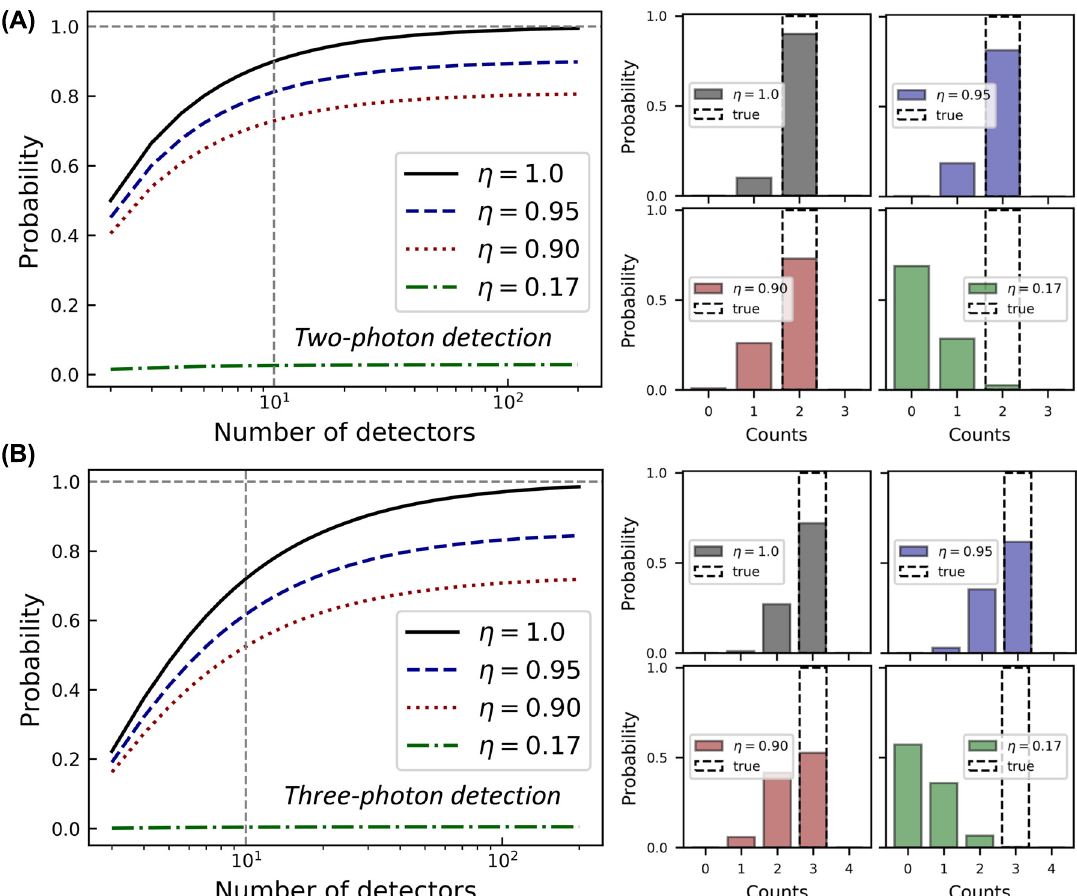
Figure 6: Photon number resolution with coherent and incoherent detection. (A, left): The probability of getting two clicks assuming detection of a two-photon number state as a function of the number of constituent detectors. Efficiency of each constituent detector is 100% (solid black line), 95% (dashed blue line), 90% (dotted red line), and 17% (dash-dotted green line). (A, right): The distribution of detection clicks for these four scenarios. (B) Same but for detection of a three-photon number state. For conventional incoherent schemes: the probability of correct photon number measurement drops exponentially with the efficiency of constituent detectors. For a coherent scheme with a distributed detector: efficient photon number resolution can be implemented with inefficient constituent